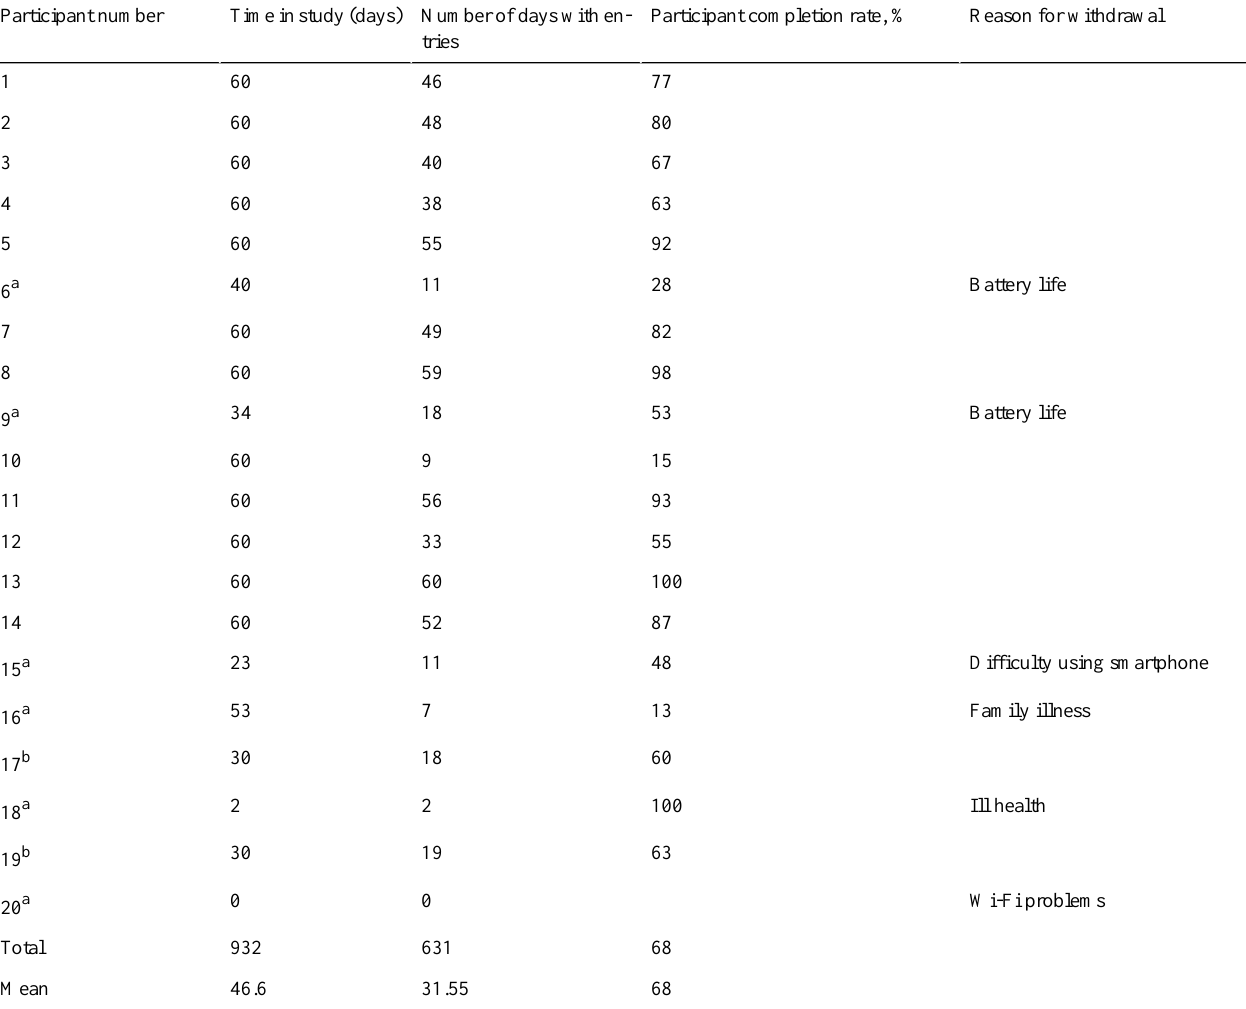
Table 1. Completeness of self-reported data entry.